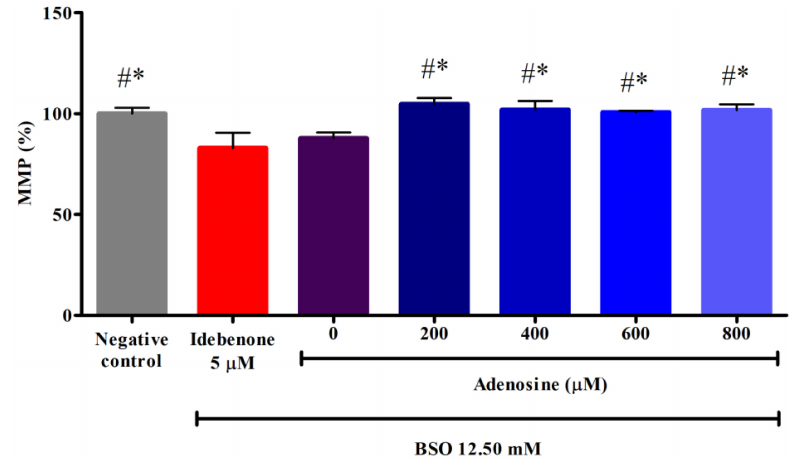
Figure 2. Effects of adenosine on the MMP in FRDA fibroblasts treated with BSO. The MMP was evaluated following pre-treatment with adenosine (0 to 800 µ M) for 2 h and 12.50 mM BSO for 24 h. Data are expressed as mean ± SD and statistically analyzed by one-way ANOVA with Tukey’s post-hoc test. Hash (#) and asterisk (*) indicate significant differences ( p < 0.05) in MMP compared to the idebenone group and BSO-treated (0 µ M adenosine) group, respectively. BSO, L-buthionine sulfoximine; MMP, mitochondrial membrane potential.